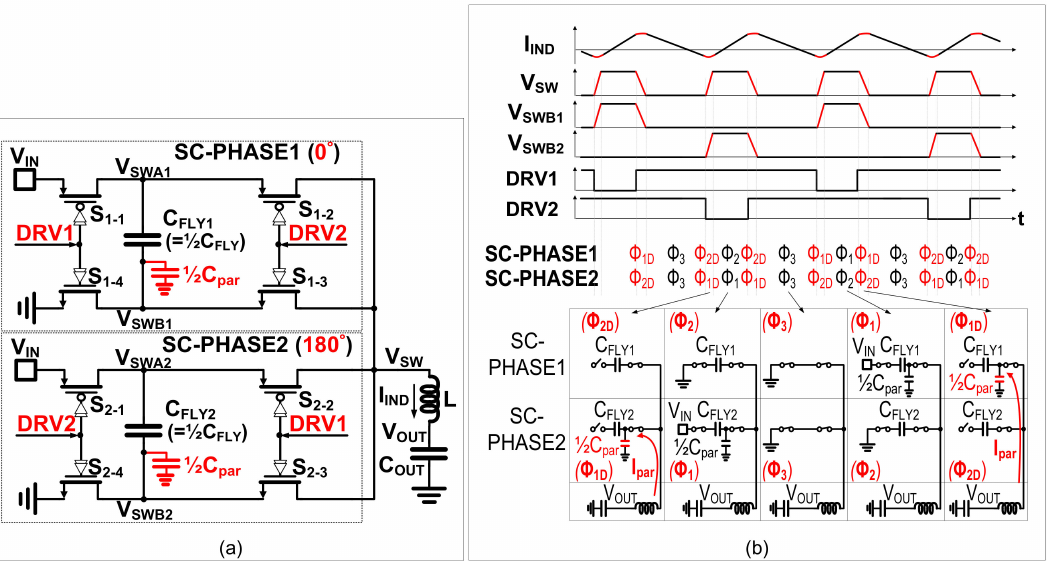
Figure 3. Proposed soft-switching hybrid DC-DC converter with the 2-phase 2:1 SC: ( a ) block diagram ( b ) timing diagram when V OUT < 1 / 2 · V IN